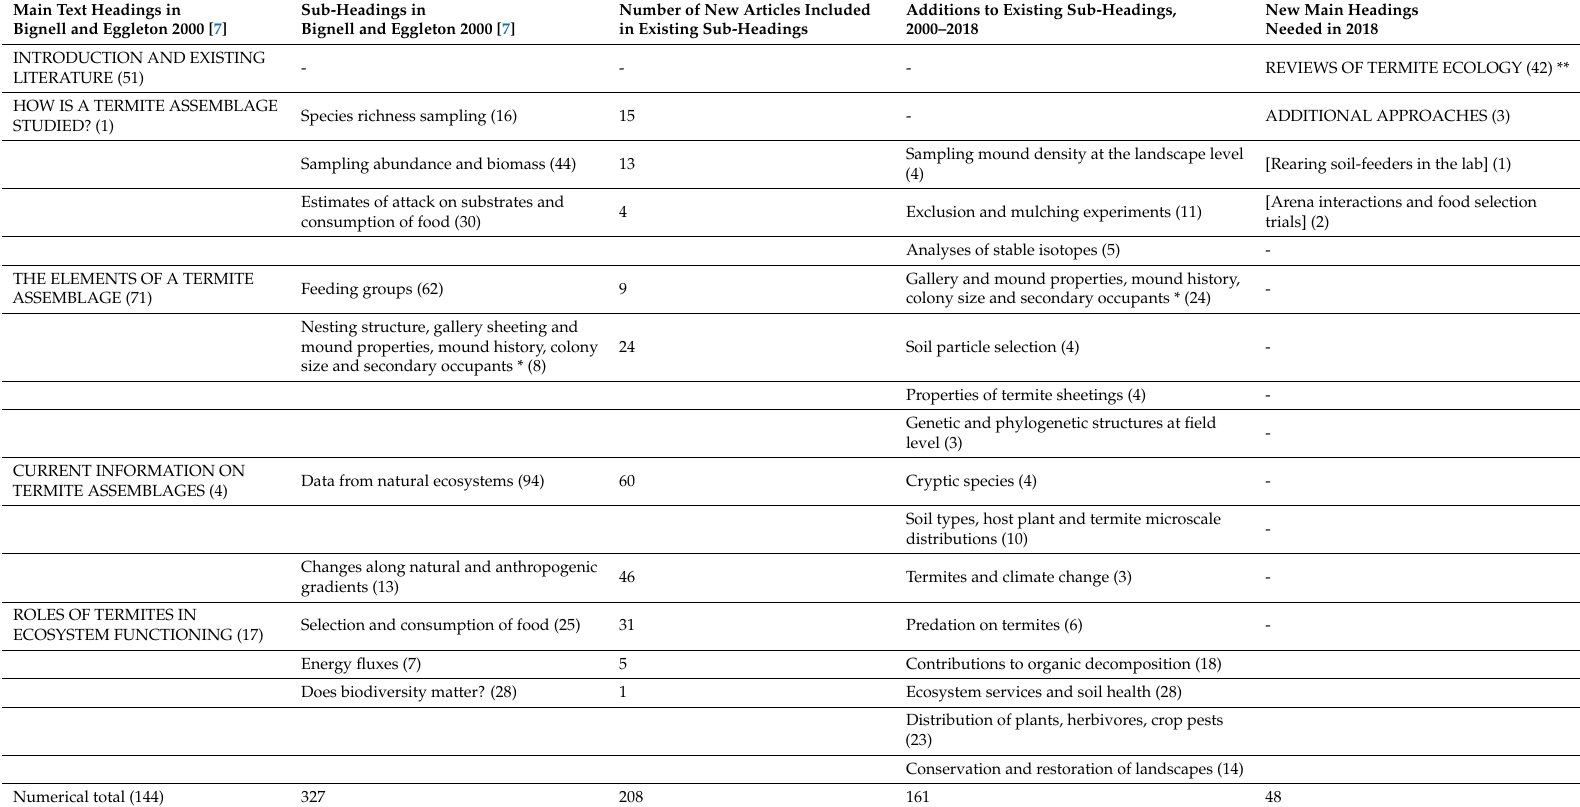
Table 2. How the literature on termite ecology has expanded and diversified in the 21st century. The table lists the headings and sub-headings in Bignell and Eggleton 2000 [7], together with the number of citations (round brackets) included under both the main text headings and subheadings, and in addition the new subheadings and citation totals that are now required to develop the scope of the Millennial review. Note that the same citation can appear in both the first and second columns. New main headings are identified in the last column. For articles published after 2000 (including those with a previous publication date, but now considered significant without being included in [7]), the number tabulated corresponds to the listing of the article on Web of Science TM , i.e., one listing earns one citation however many times the article is listed in subsequent published bibliographies. Therefore, the same citation appears in only one of columns three to